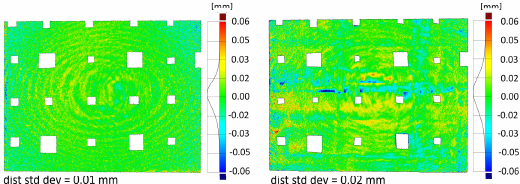
Figure 2. Surface discrepancy maps. 3D reconstruction with average mesh (left) and probe measurements (right). Instrumentation to provide an independent check is not always available for heritage projects and the resulting measures may not provide the information necessary. For example, a touch probe includes discrete points and is unlikely to give the same surface sampling density to highlight local detail, but it provided an independent check on the overall shape that did not have the same systematic errors of a photogrammetric measurement. To reflect a low-cost heritage approach, the average mesh was used for assessment in this paper, with the caveat that it is not an independent reference and accumulated the systematic errors of the reconstructions used to create